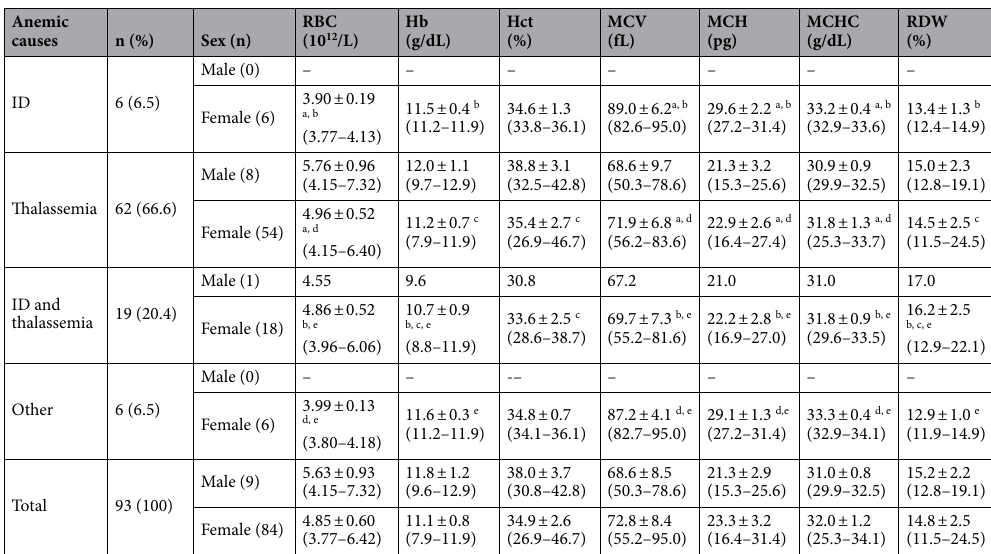
Table 3. Proportions and hematological characteristics of iron deficiency anemia (IDA), thalassemia and combined IDA and thalassemia among 93 anemic subjects inhabiting at the border region of Thailand, Lao PDR and Cambodia (hematological data expressed as mean ± SD and min–max in parentheses). a Significant difference between iron deficiency and thalassemia female subjects ( P < 0.05). b Significant difference between iron deficiency and combined iron deficiency/thalassemia female subjects ( P < 0.05). c Significant difference between thalassemia and combined iron deficiency/thalassemia female subjects ( P < 0.05). d Significant difference between thalassemia and other anemic female subjects ( P < 0.05). e Significant difference between combined iron deficiency/thalassemia and other anemic female subjects ( P < 0.05).